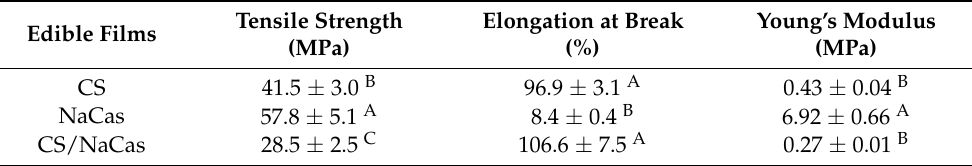
Table 3. Tensile strength, elongation at break, and Young’s modulus of chitosan and sodium caseinate edible films. Tensile Strength Elongation at Break Young’s Modulus Edible Films (MPa) (%) (MPa) CS 41.5 ± 3.0 B 96.9 ± 3.1 A NaCas